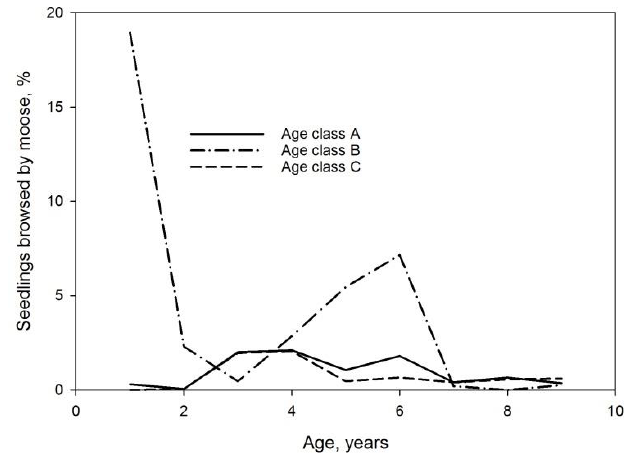
Figure 6. Amount of sprouts damaged by moose.